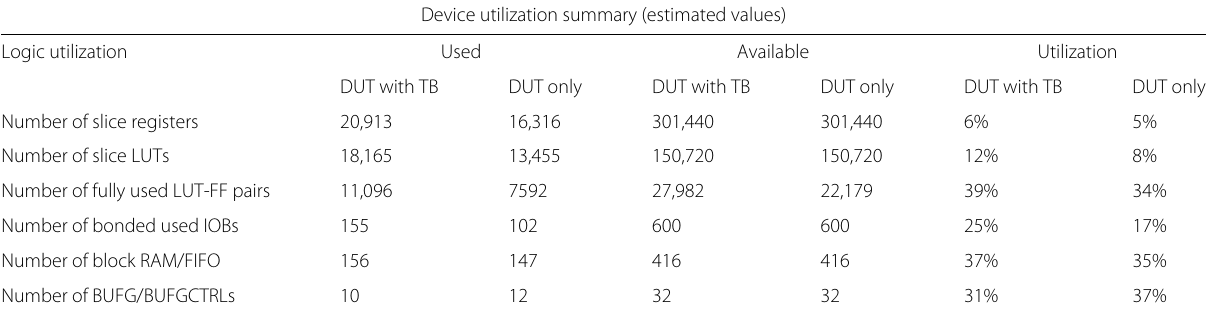
Table 4 FPGA resource occupation comparison. DUT with TB: FPGA occupation resources with test-bench included. DUT only: FPGA occupation resources DUT